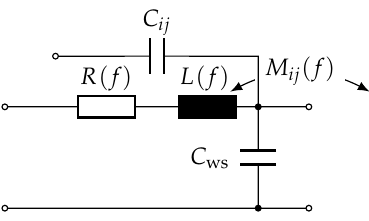
Figure 5. Single-turn model with frequency-dependent turn resistance R , self-inductance L , mutual inductance M , and frequency-independent capacitance C .